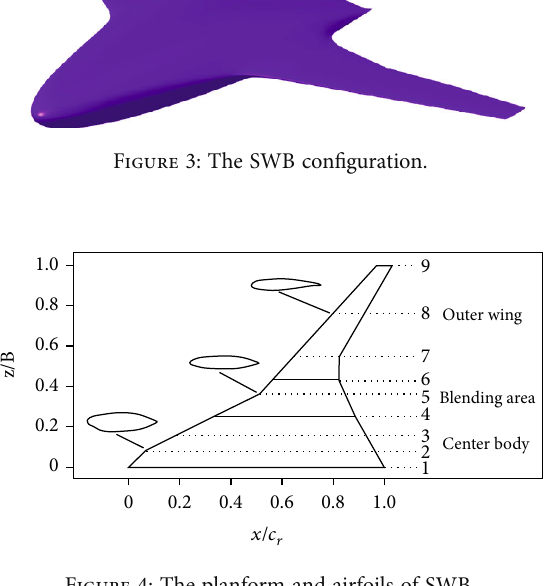
Figure 4: The planform and airfoils of